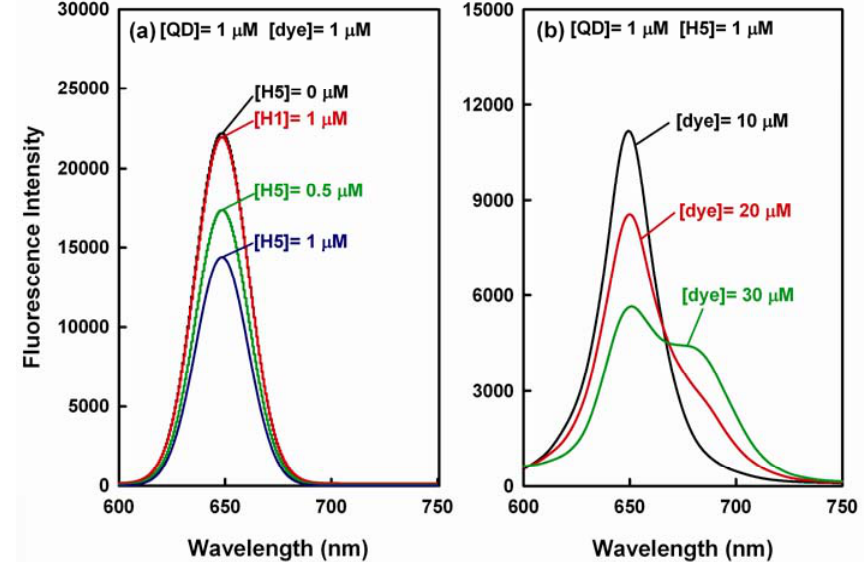
Figure 5. The emission spectra of the sandwich hybridization with a high FRET donor concentration ([QD] = 1 μ M): ( a ) hybridization with different amounts of H5 target ([H5] = 0, 0.5, and 1 μ M) and a fixed amount of FRET acceptor ([dye] = 1 μ M) and a negative control study in which non-target 60-mer H1 sequence ([H1] = 1 μ M) was hybridized with QD-dye FRET pair ([QD] = [dye] = 1 μ M) to evaluate the detection specificity of the QD-dye FRET pair; ( b ) hybridization with a fixed amount of H5 target ([H5] = 1 μ M) and different amounts of FRET acceptor ([dye] = 10, 20, and 30 μ